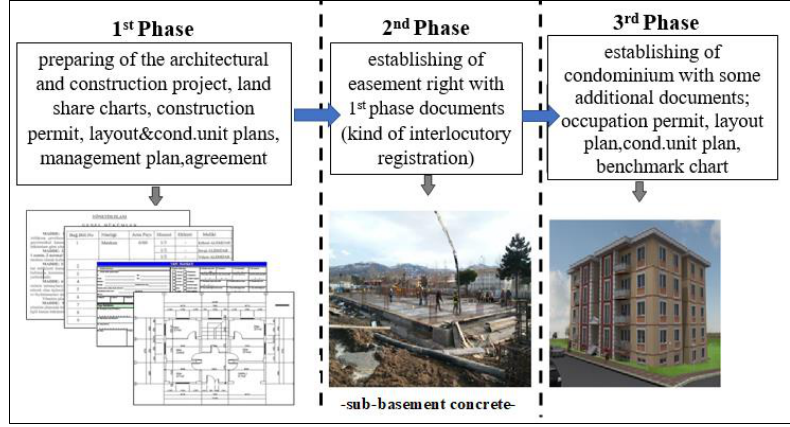
Figure 3. The process of establishing easement right and condominium